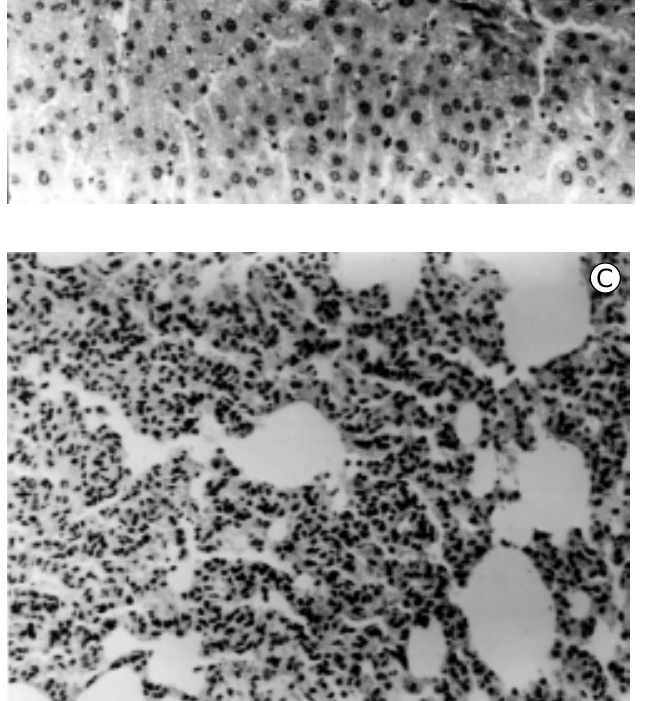
Figure 1. Histological sections from rats submitted to ligature of both ureters (A) and ligature of both ureters plus nephrectomy (B and C). A , Renal medullar tissue presenting mild dilation of tubules and atrophy of the tubular epithelial cells. B , Hepatic parenchyma showing hepatocellular steatosis. C , Pulmonary parenchyma pre- senting small alveolar focuses of inflammatory cell infil- tration. Hematoxylin and eosin stain. Magnification